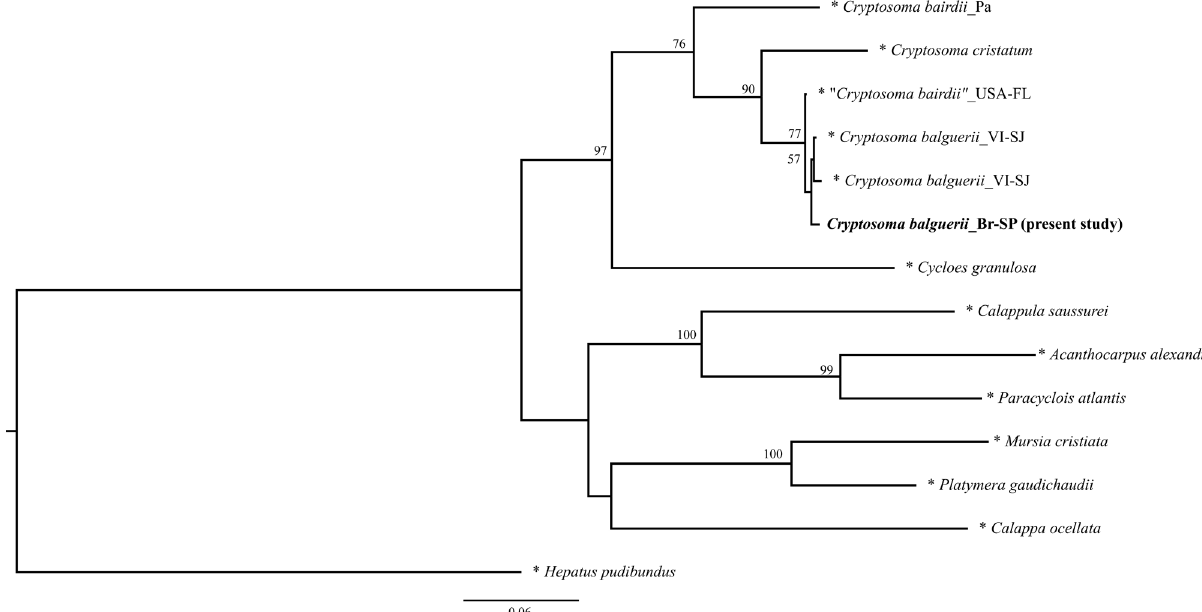
Figure 1. Phylogram based on Maximum Likelihood analysis of partial fragments of 16S and COI to place Cryptosoma balguerii from São Paulo (Brazil) within the context of Calappidae based on sister genera. GenBank sequences are marked with an asterisk (*); Br-SP: São Paulo State, Brazil; Pa: Gulf of Panama; USA-FL: Florida, United States of America; VI-SJ: St John Island, Virgin Islands; quoted species name suggests misidentification; bootstrap values under 50% are not